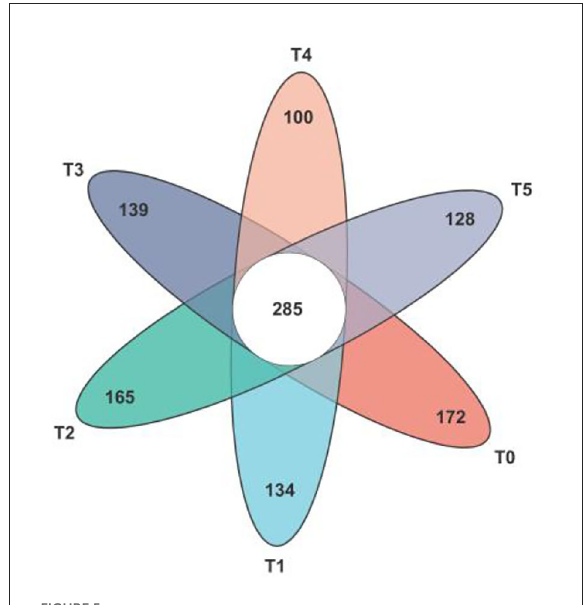
FIGURE5 Venn diagram of the gut microbiota composition in Cobb broilers shows the number of shared and unique core ASVs among the six study groups. T0: fed diets based on SBM as the only protein source; T1, T2, T3, T4, T5: 1, 2, 3, 4, and 5% of CAP were